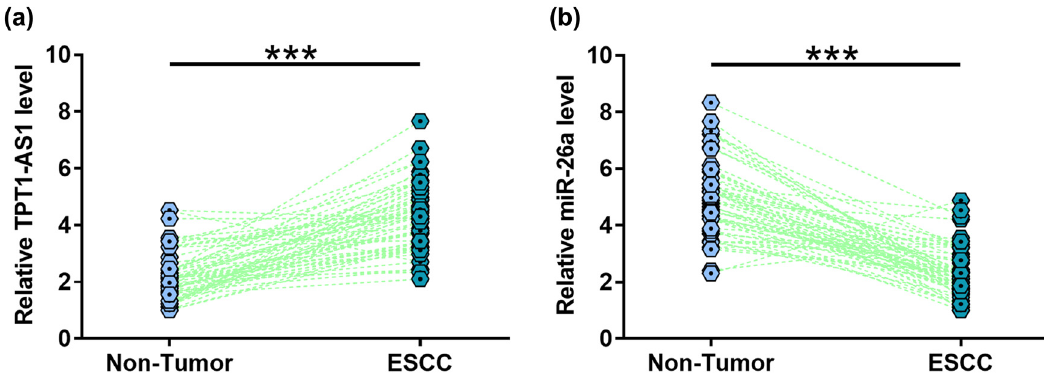
Figure 2: TPT1 - AS1 level was increased, while miR - 26a level was reduced in ESCC tissues. TPT1 - AS1 ( a ) and miR - 26a ( b ) levels in ESCC and matched non - tumor tissues were measured by RT - qPCR. ***, p <